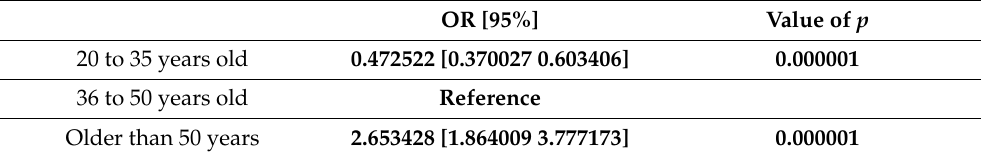
Table 9. Odds ratios of psychological (emotional) symptoms of fear and age groups.